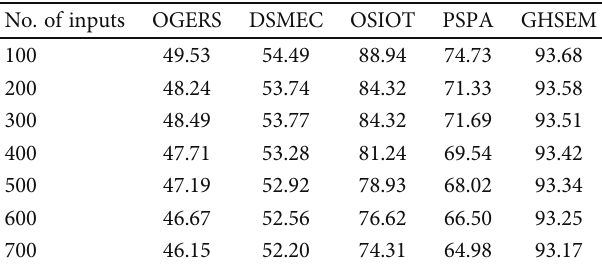
Table 1: Comparison of pipeline integrity tests.